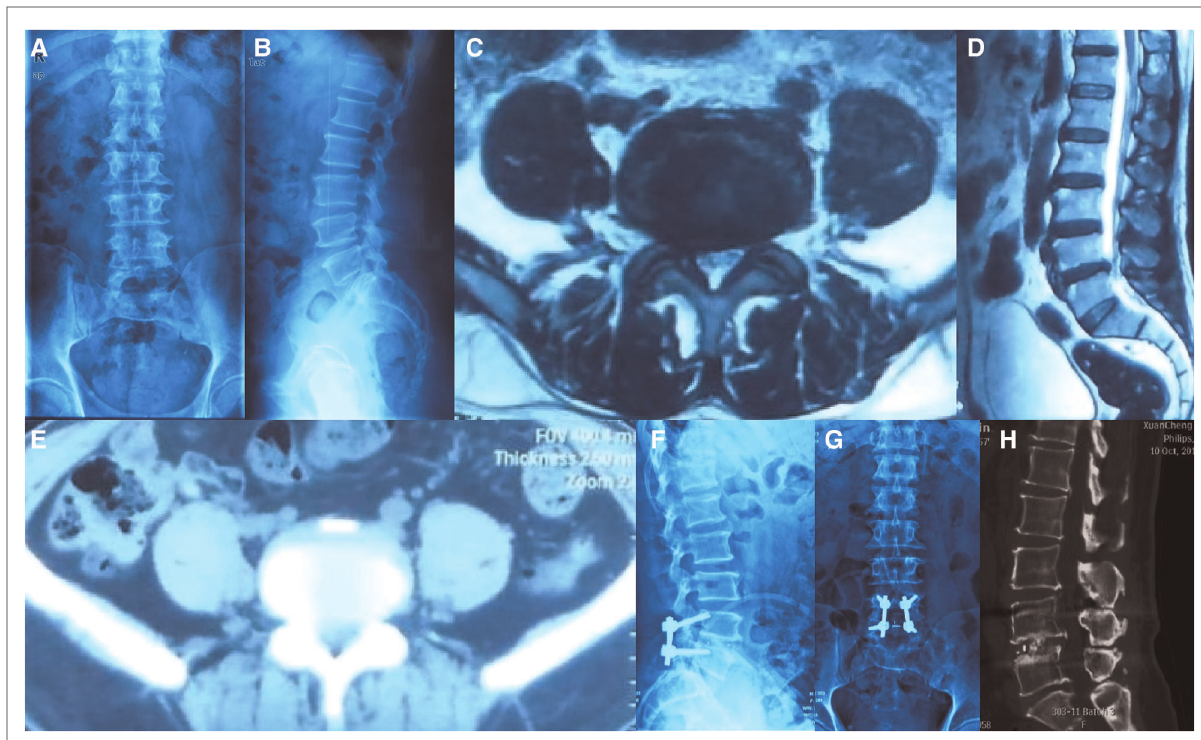
FIGURE 2 A fi fty-two-year-old male patient, presented with low back pain radiating to the left leg for almost 5 years and numbness of both lower limbs for almost 4 years. Physical examination showed that the straight leg raising test of the left leg was positive (60°), decreased muscle power for left tibialis anterior (Manual Muscle Test grade IV), Eaten( − ), Spurling( − ). MRI revealed a herniation disc at L4/L5 level. Postoperative x-ray showed perfect bone fusion and no internal fi xation was a failure. ( A,B ) preoperative anteroposterior x-ray; ( C ) preoperative CT of L4/L5; ( D ) preoperative MRI; ( E,F ) anteroposterior x-ray of 2-years-after-surgery lumbar spine. ( H ) Postoperative sagittal